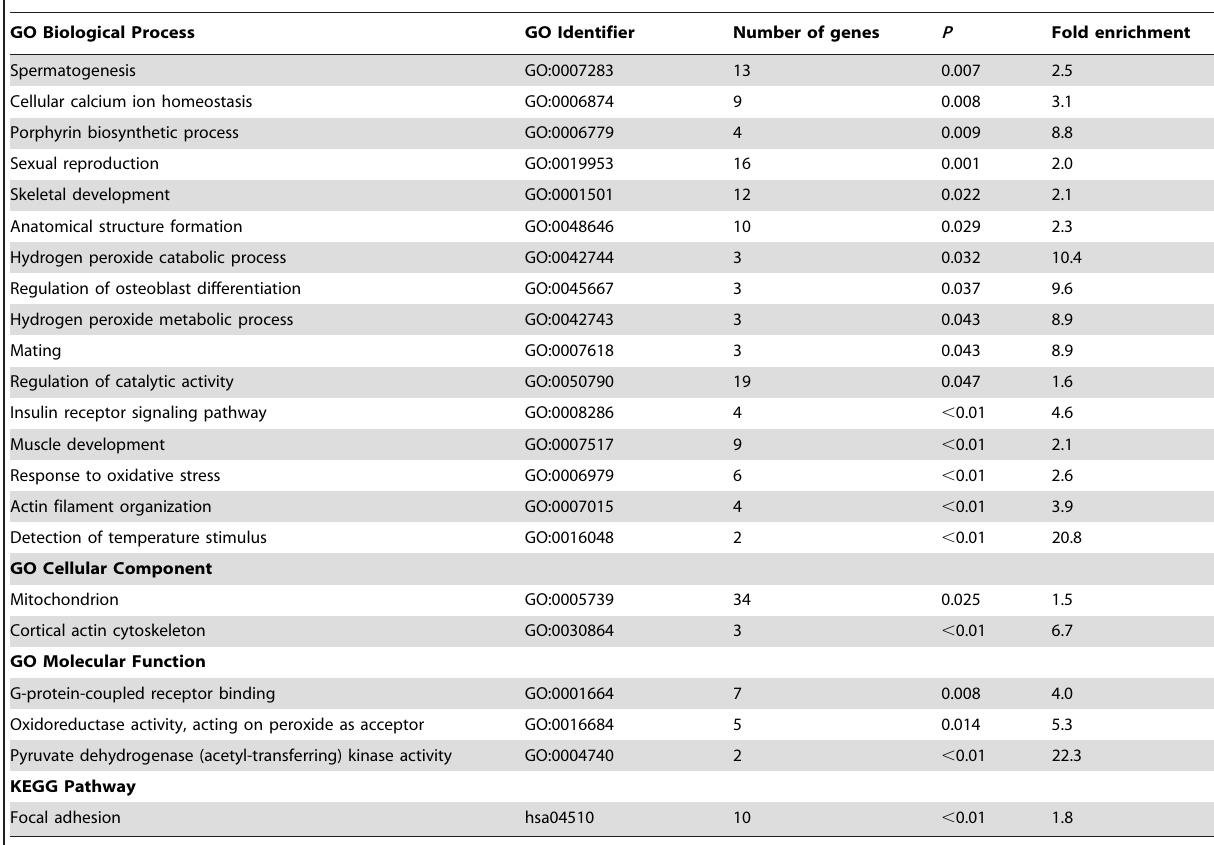
Table 3. Overrepresented gene ontologies ( F ST